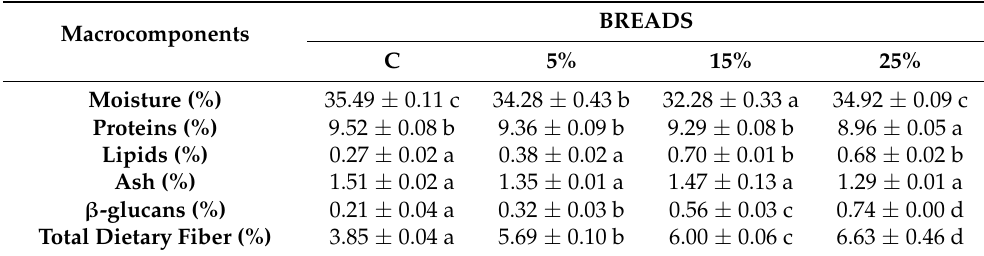
Table 7. Percentage composition of wheat bread (C) and breads with mixtures of oat–wheat flours: 5, 15, and 25%.